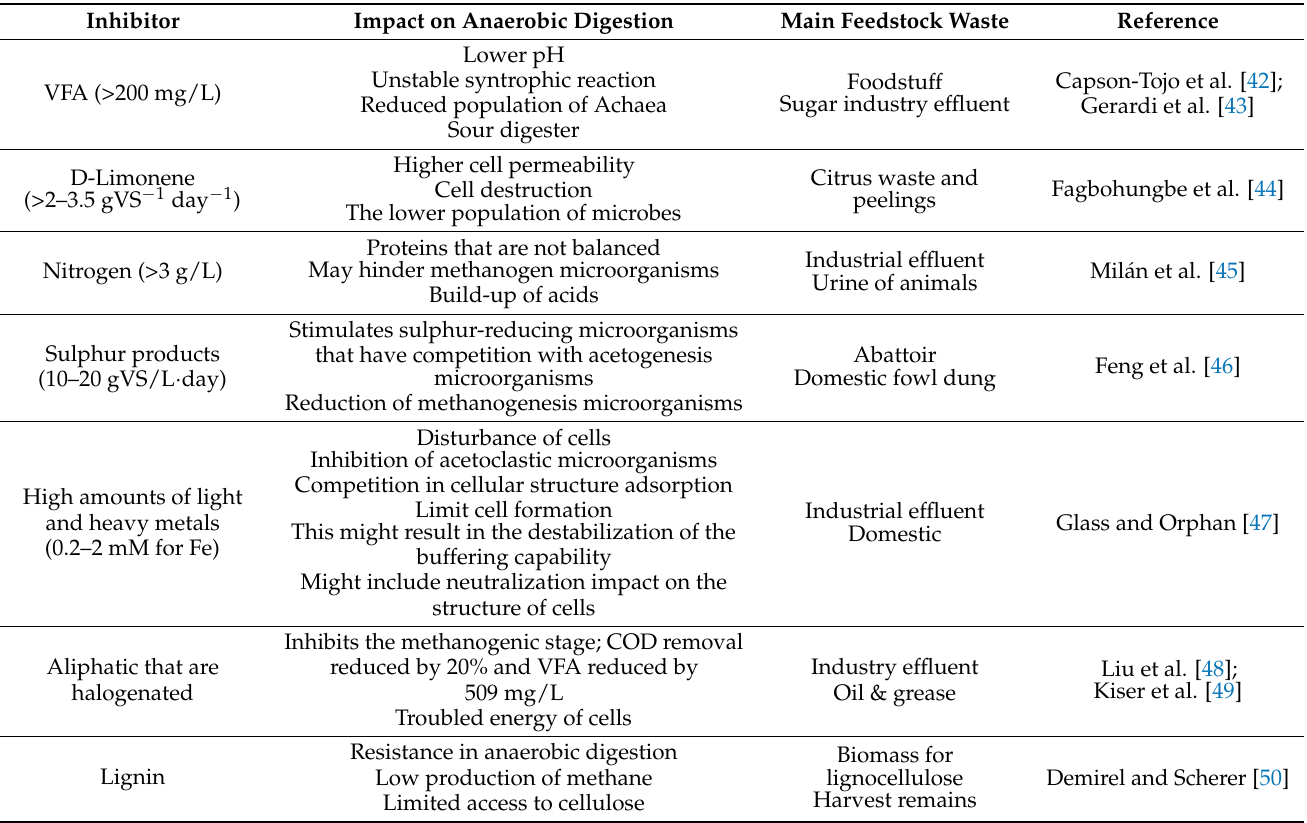
Table 1. Inhibitory effect in anaerobic digestion